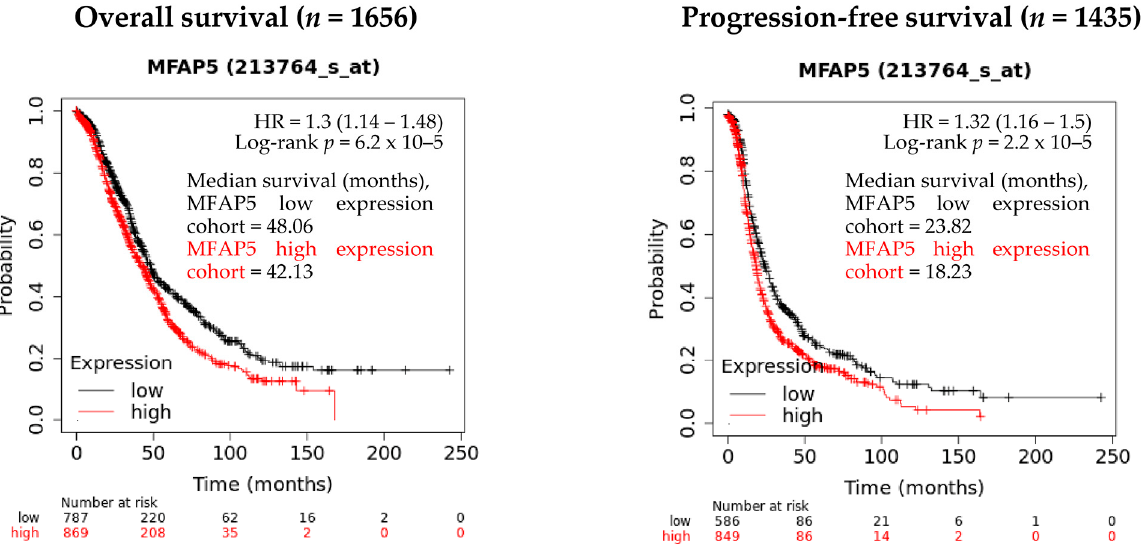
Figure 1. The evaluation of MFAP5 mRNA expression relevance in regard to OS and PFS using the Kaplan-Meier Plotter database. Low and high expression cohorts stratification was based on the best cutoff value automatically selected by KMP (13 June 2022).